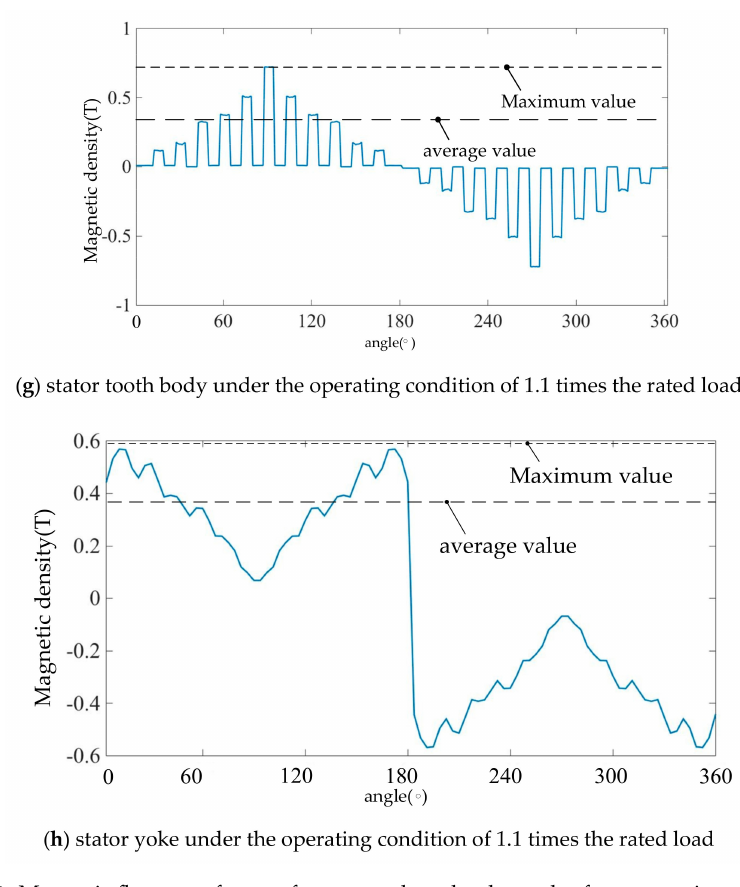
Figure 10. Magnetic flux waveforms of stator teeth and yoke under four operating conditions.